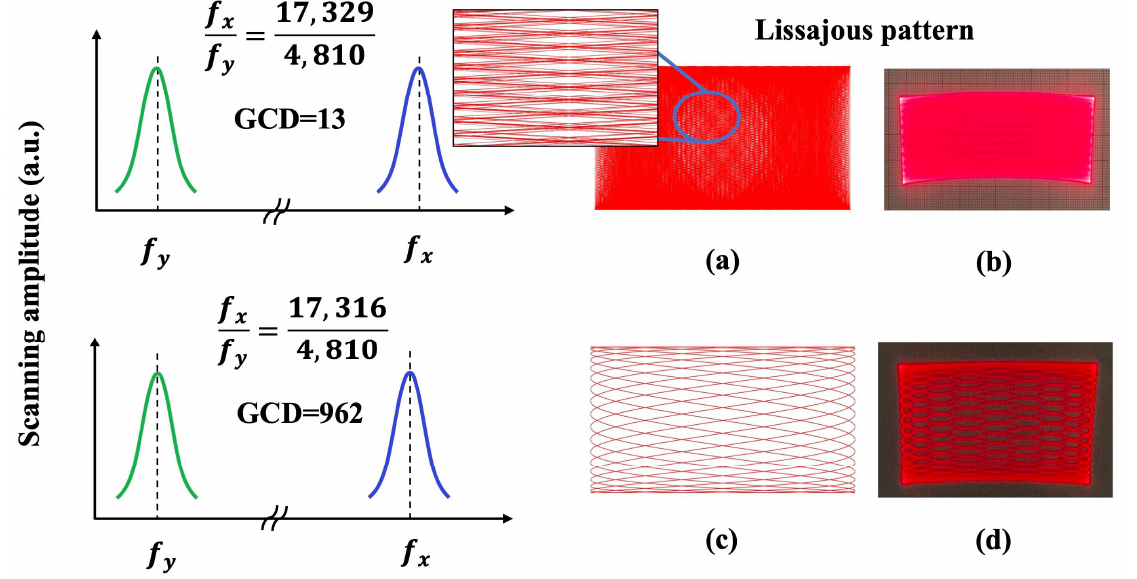
Figure 7. The relationship between the scanning frequency of the MEMS mirror and the projected Lissajous pattern. Note that f x and f y infer the resonant frequency of the fast-axis and the slow-axis of MEMS mirror, respectively. The density of the Lissajous pattern decreases as the great common divisor (GCD) of bi-axial scanning frequencies ( f x and f y ) increases. ( a , b ) f x = 17,329 Hz, f y = 4810 Hz, GCD = 13. ( c , d ) f x = 17,316 Hz, f y = 4810 Hz, GCD = 962. Where ( a , c ) were generated by algorithm simulations, ( b , d ) were generated by actual laser patterns